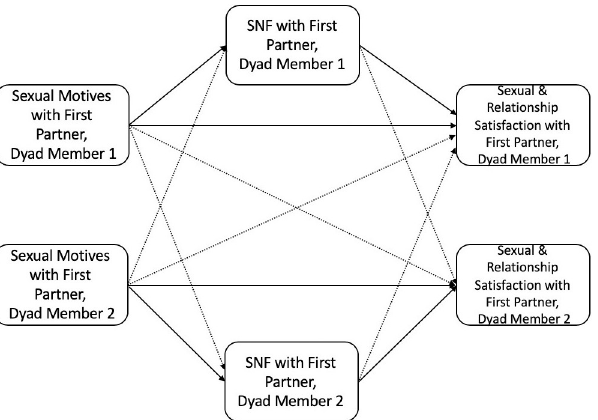
Fig 1. SDT model for sexual motives, sexual need fulfillment, and sexual/relationship satisfaction within the primary dyad. Notes: Solid lines indicate actor effects; dashed lines indicate partner effects; dyad members include CNM partners living with one another (often considered a “primary” partner, referred to as “first partner” in Fig 1); SNF = sexual need fulfillment.